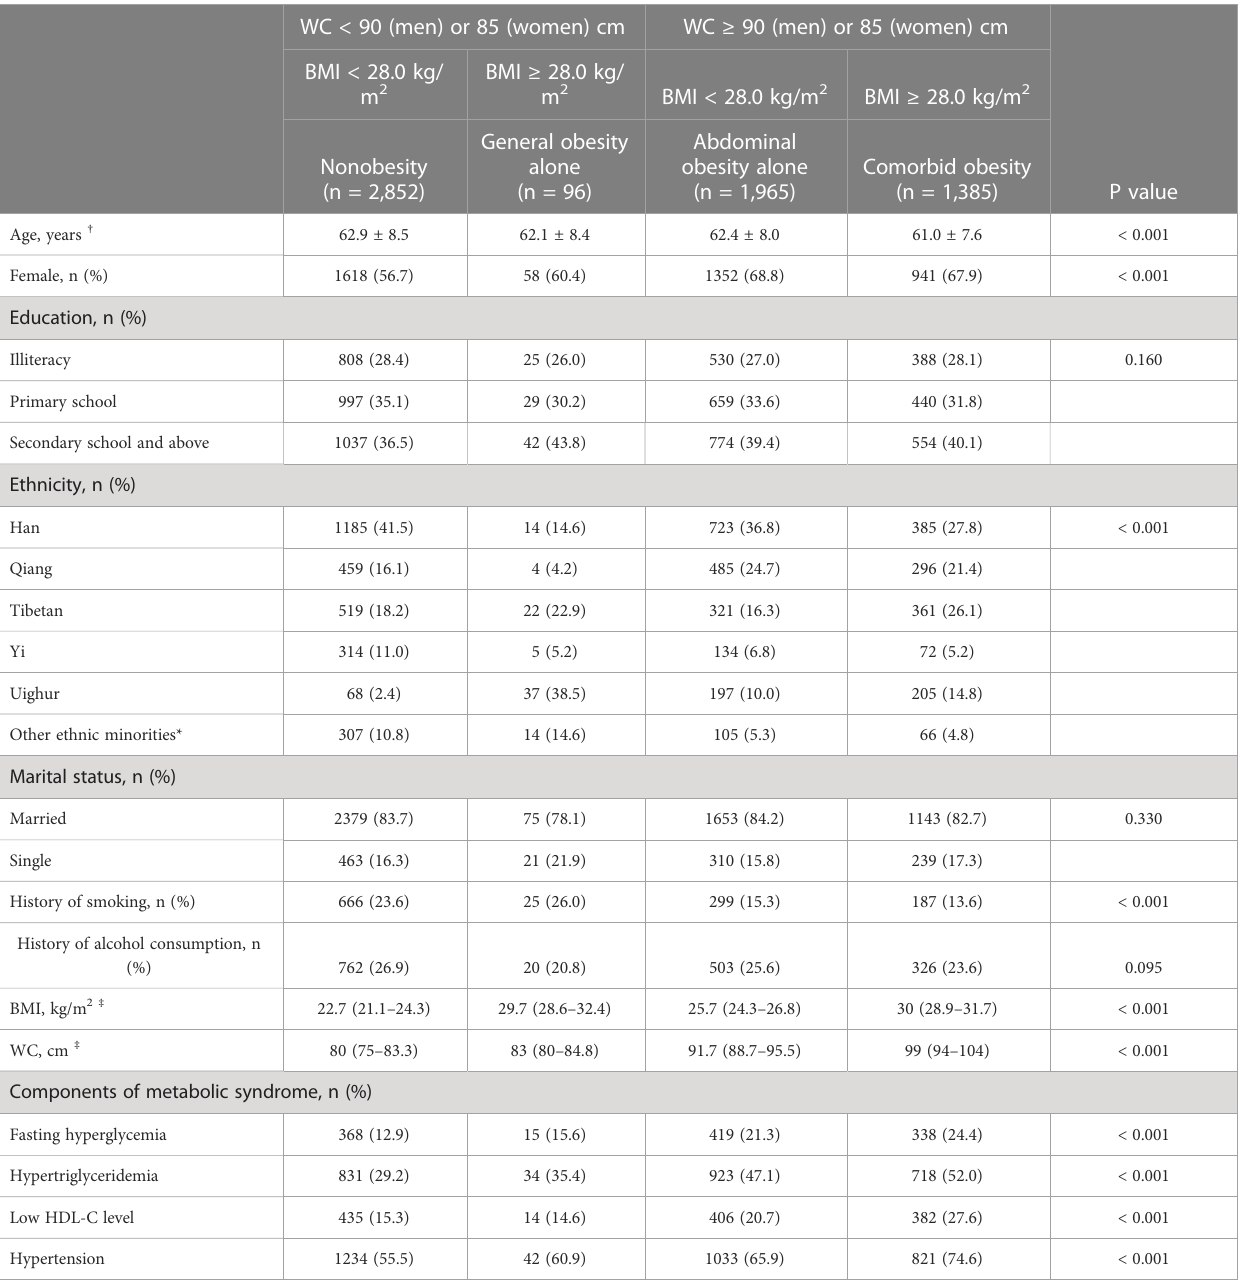
TABLE 1 Characteristics of study participants by obesity